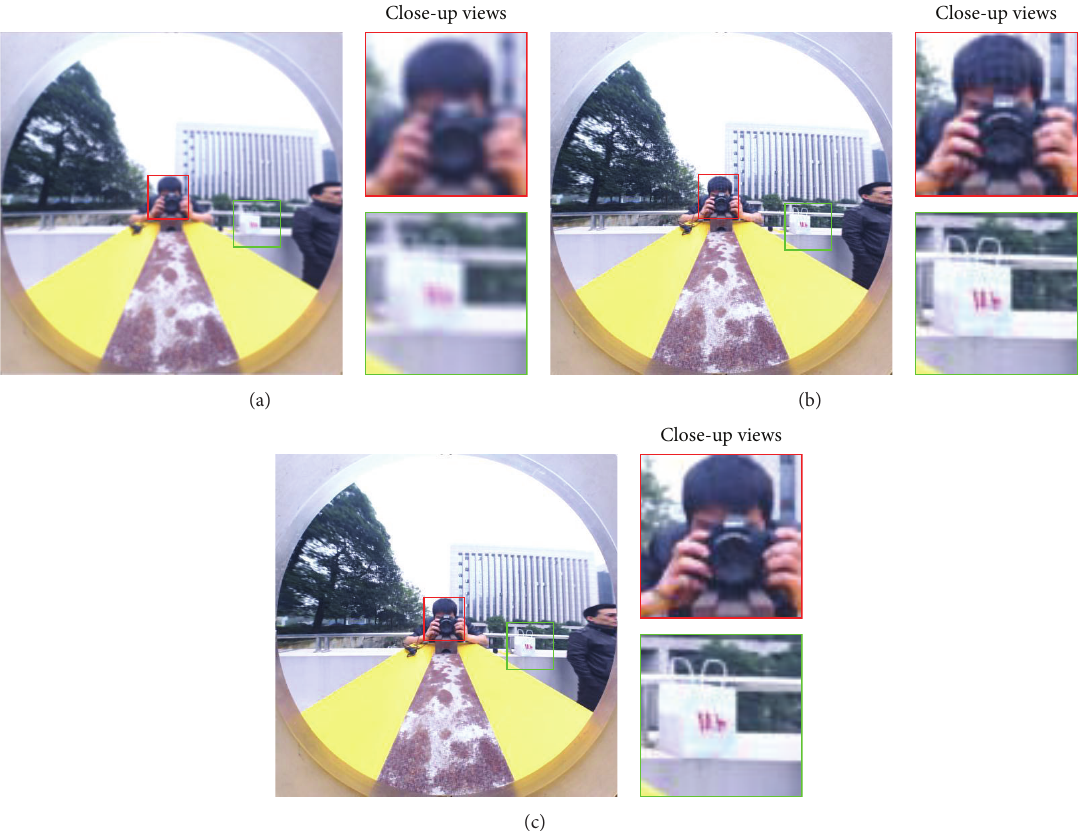
Figure 10: Defocus deblurring results of real image captured by our experimental setup: (a) blurry omnidirectional image; (b) deblurred results using TwIST algorithm; (c) deblurred results using our proposed method